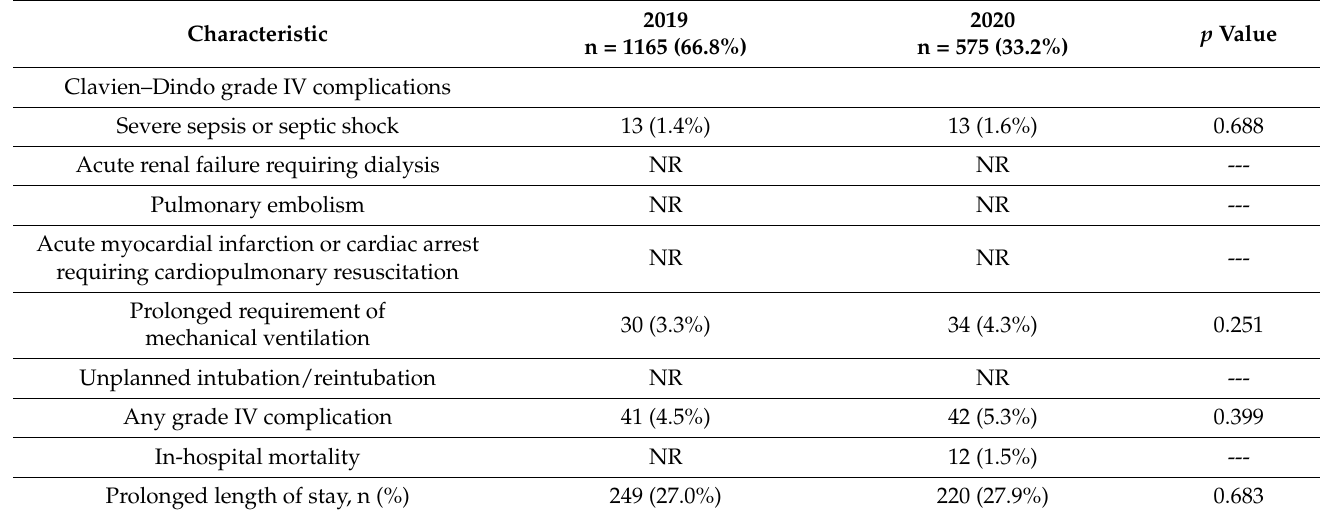
Table 2. Clinical outcomes of hospitalizations for intracranial meningioma resection during 2019